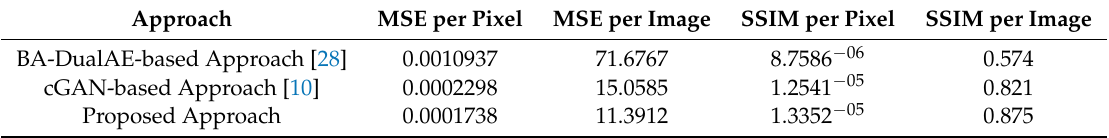
Table 1. MSE and SSIM based on reconstructing input test samples using the NYU dataset [30].